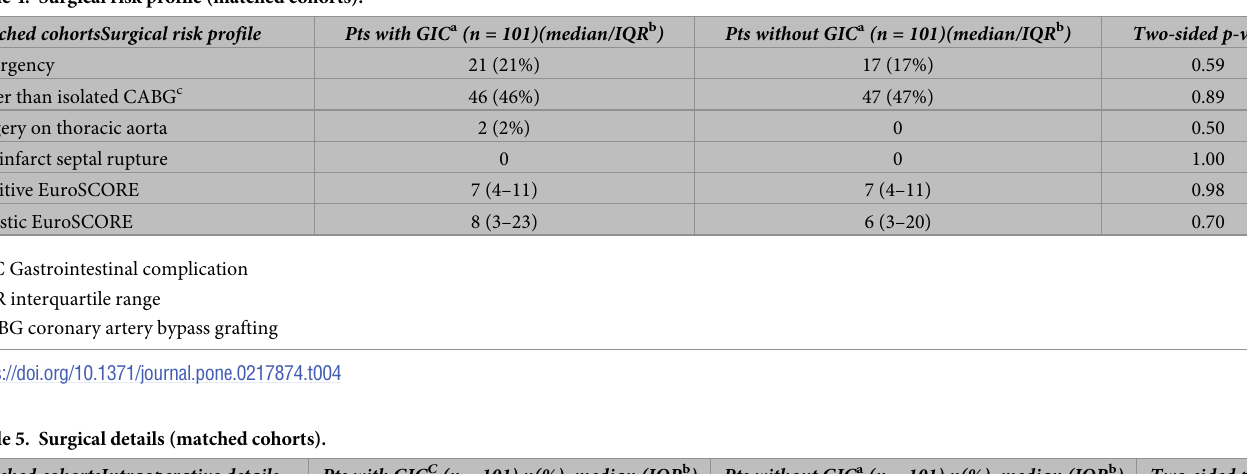
Table 4. Surgical risk profile (matched cohorts).